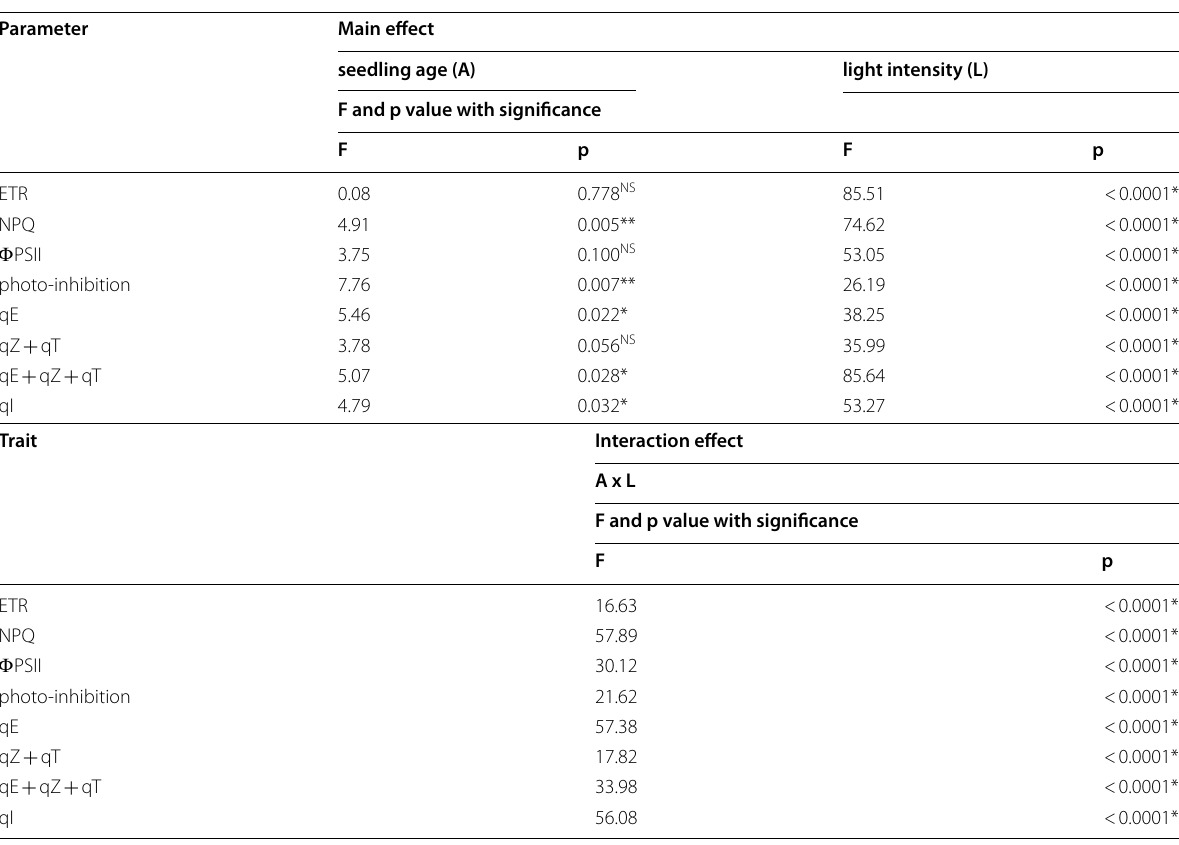
Table 1 Analysis of variance of the seedling age (A) and light intensity (L), and their interactions (A inhibition, qE, qZ qT, qE qZ qT and qI of plant. Measurements were made at 25 °C under 50, 100, 300, 500, 1,000, 1,500, + + +